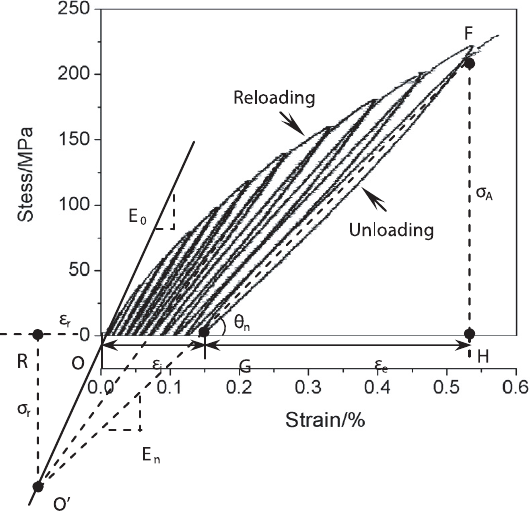
Fig. 2. Tensile stress-strain curve of a 2D C/SiC CMC with interrupted unloading/reloading